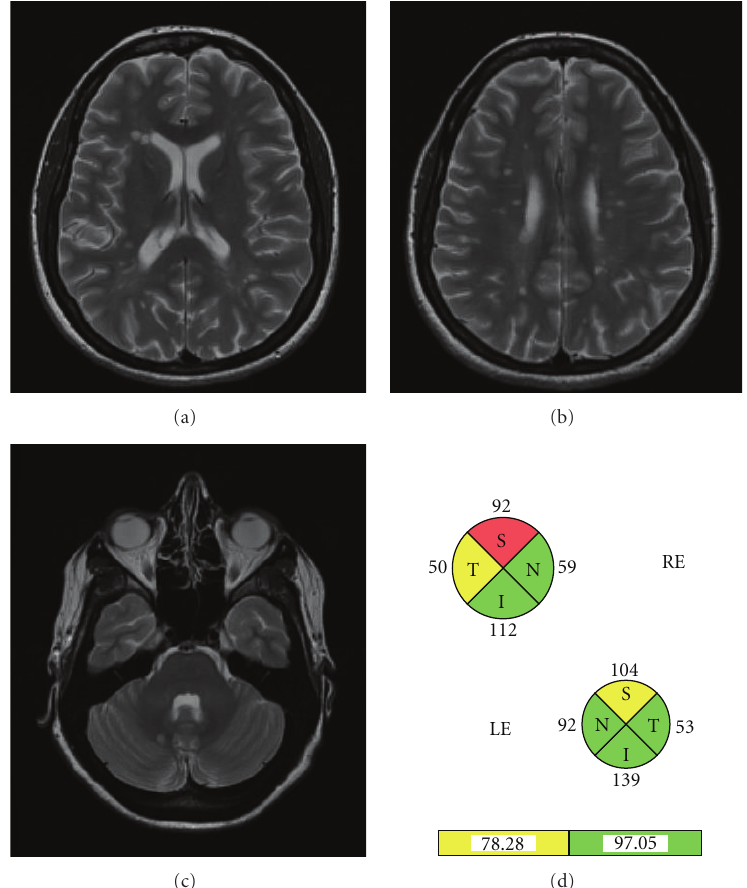
Figure 3: Patient who su ff ered a motor clinical isolated syndrome and fulfilled Barkhof’s magnetic resonance imaging criteria. Optical coherence tomography shows a decreased retinal nerve fiber layer in both eyes (more intense in the right eye) even without a history of optic